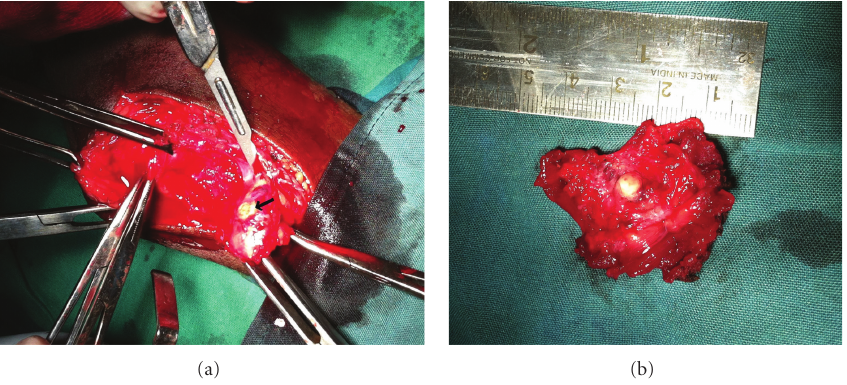
Figure 4: Vascular mass in the vastus medialis muscles with calcifications was encountered (calcification marked with black arrow).